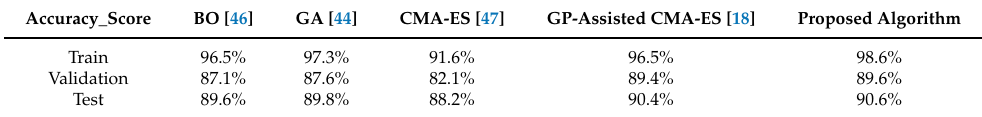
Table 2. Simulated results of all experimental algorithms with 1000 spiking neurons on MINIST.